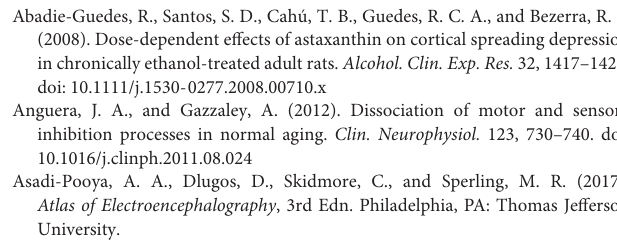
FIGURE S1 | CSD features in ethanolc˛-treated Wistar rats of different ages. (A) recording of the slow DC potential change that is typical from CSD. Recordings are from two rats with 3 months (upper traces) and 6 months of life (lower traces). CSD was elicited by 1-min application (at the time marked with a black horizontal bar under trace 1) of a cotton ball (1-2 mm diameter) soaked in KCl 2% solution. One can note, in the older animal, the longer latency for a CSD wave to cross the interelectrode distance, indicating lower velocity, compared with the younger rat. (B) skull diagram showing the place of the reference electrode (R) on the nasal bones, the KCl application site (KCl) on the frontal bone, and the recording points 1 and 2 on the parietal bone. (C) velocity of CSD propagation in 3-months old (white bars) and 6-months old (gray bars) Wistar rats that were treated with water (control group) or 3 g/kg ethanol for 21 days. Data are expressed as mean ± standard deviation. ∗ p < 0.05, ethanol group different from the water group. # p < 0.05, 6-months old different from the 3-months old group. This unpublished figure is based on data from our previously published papers (Abadie-Guedes et al., 2012, 2016). FIGURE S2 | Examples of Electrocorticogram (ECoG) from three Wistar rats that are representative of the control group and two groups that were subjected to swimming exercise early in life (P8–P23), or late in life (P60–P75). ECoG after CSD presents higher amplitude compared with the ‘before CSD’ traces. This unpublished figure is based on data from our previously paper (Silva-Gondim et al., 2017). TABLE S1 | Examples of Brain morphological and physiological features that change as a function of